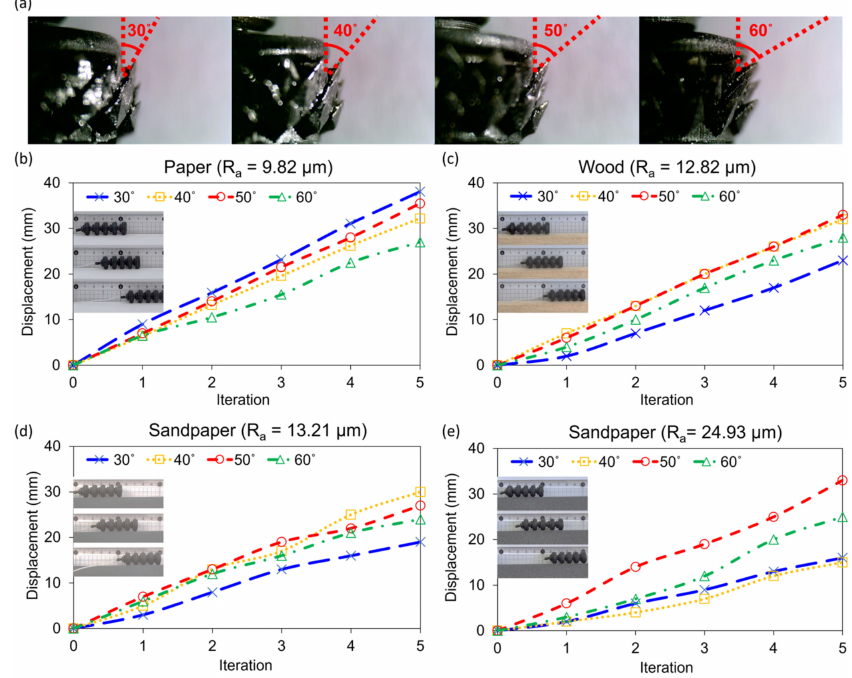
Figure 4. Characteristics depending on the angle between the horizontal axis and the anchor plane of the snake scale structure. ( a ) Close-up image of snake scale structure designed from 30 ◦ to 60 ◦ (red dotted line representing the angle of the anchor face of the calculated 3D design). Displacement according to the operating cycle of MSSR, which is made of five modular soft actuator units, on ( b ) paper, ( c ) wood surfaces and sandpapers with two different surface roughness (( d ) 13.21 µ m, ( e ) 24.93 µ